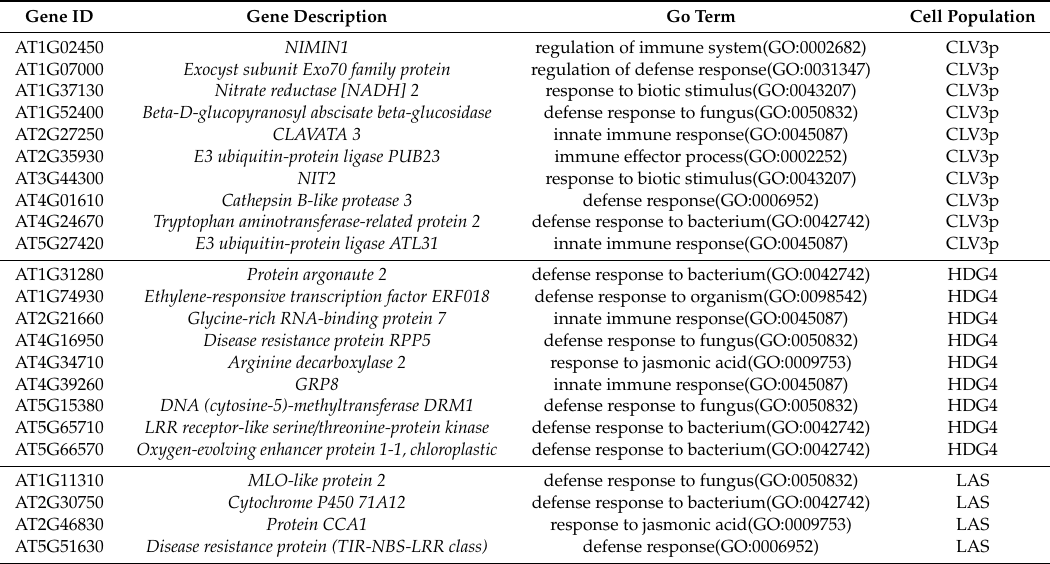
Table 2. Immune defense functions of DEGs of Sector I, the CLV3p, HDG4, and LAS cellular